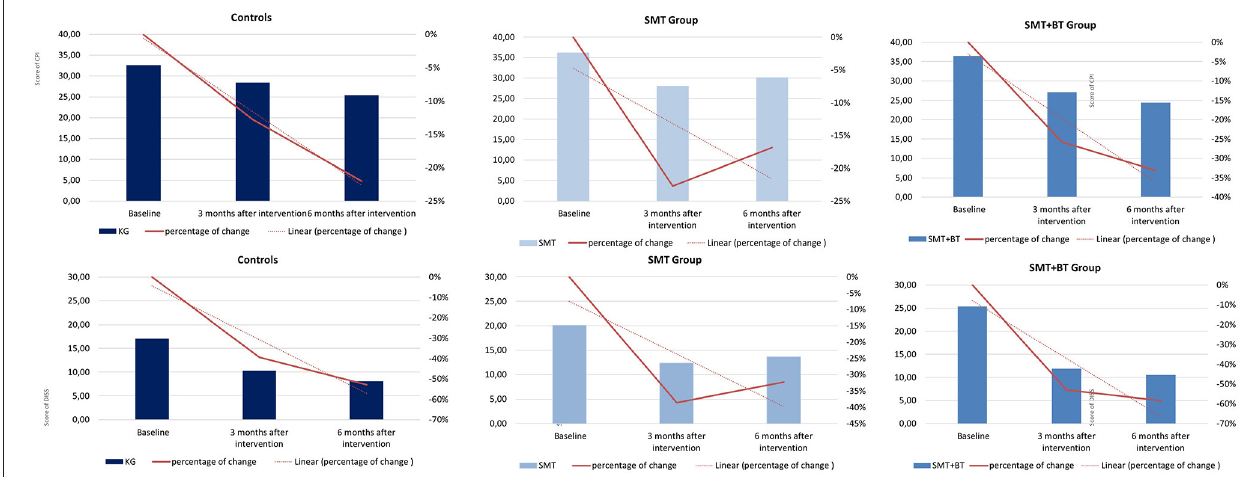
FIGURE 4 | Graphical demonstration of the improvement of pain in percentage from baseline (M1) up to 12 weeks (M4) and 24 weeks (M5) in all groups (pain intensity [above] and pain disability